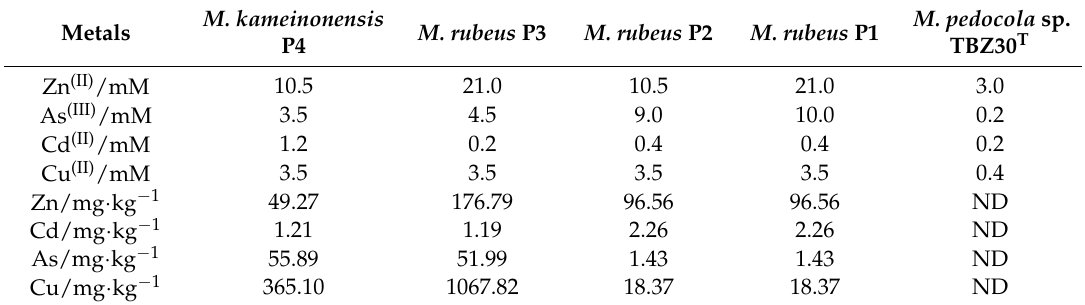
Table 2. Minimal inhibitory concentration (MIC) of strains to Zn (II) , As (III) , Cd (II) , and Cu (II) and respective concentrations of the HM in the soil where the strains were isolated from.